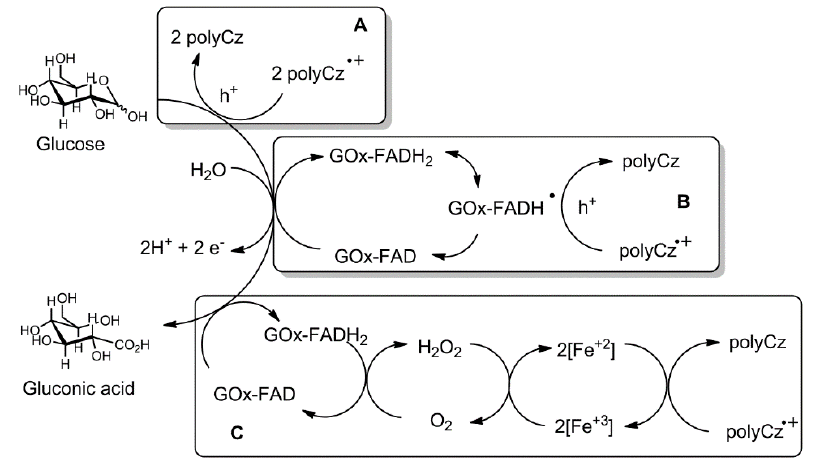
Figure 6. Possible glucose sensing mechanisms: A -direct glucose oxidation on the electrode; B -direct hole transfer between GOx-FAD and polyCz; C -H 2 O 2 -based mechanism on the poly-Fe/GOx electrode.